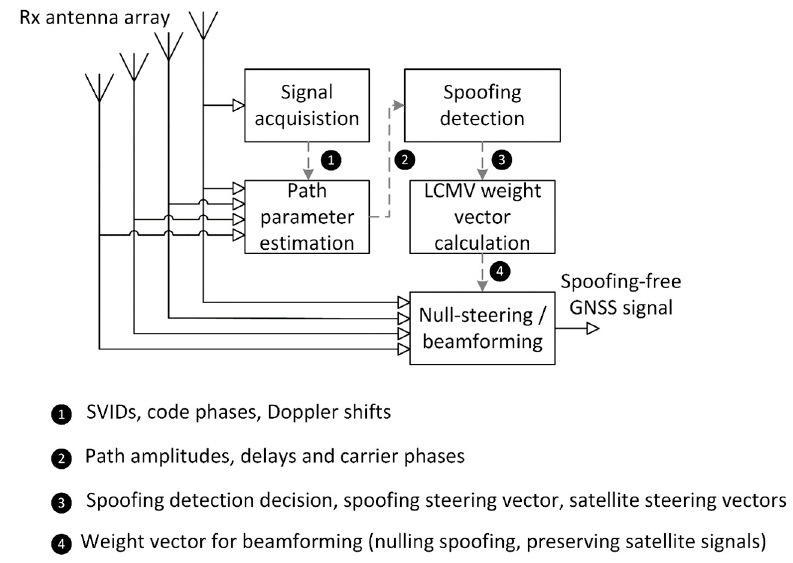
Figure 2. Scheme for detecting and mitigating intermediate GNSS spoofing